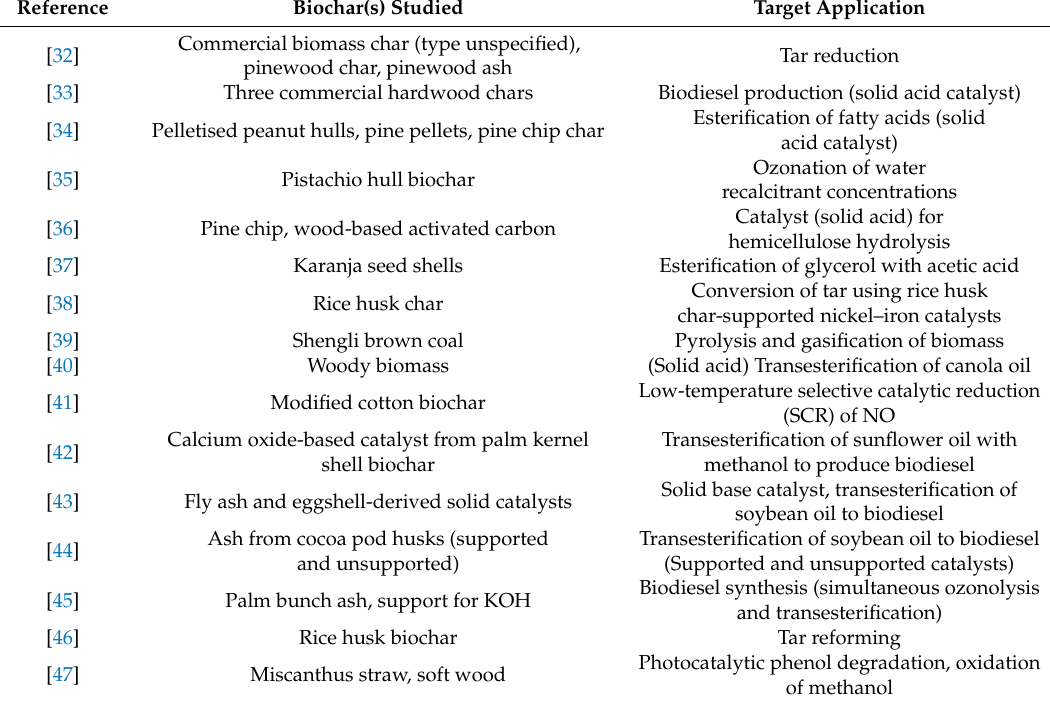
Table 1. A sample of literature sources studying biochar for catalytic